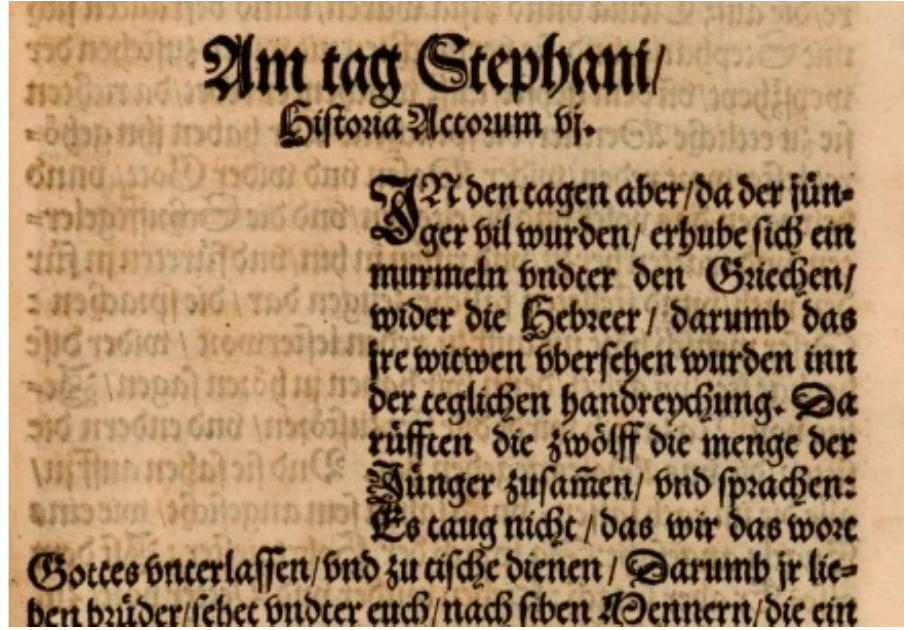
Figure 12. Empty space next to the pericope for St Stephen’s feast in (Luther 1548, part 3, fol. XIV) (Munich, Bayerische Staatsbibliothek, 2 Hom. 281, urn:nbn:de:bvb:12-bsb10144040-5; NoC-NC/1.0).